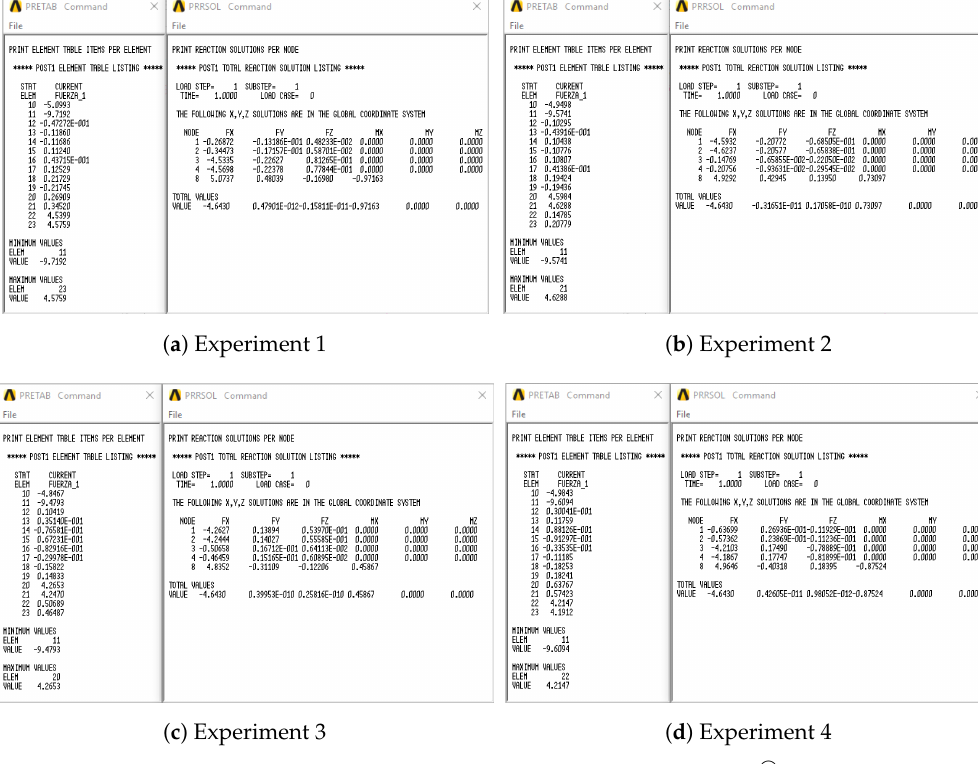
Figure 10. Static analysis results obtained from ANSYS c (cid:13)